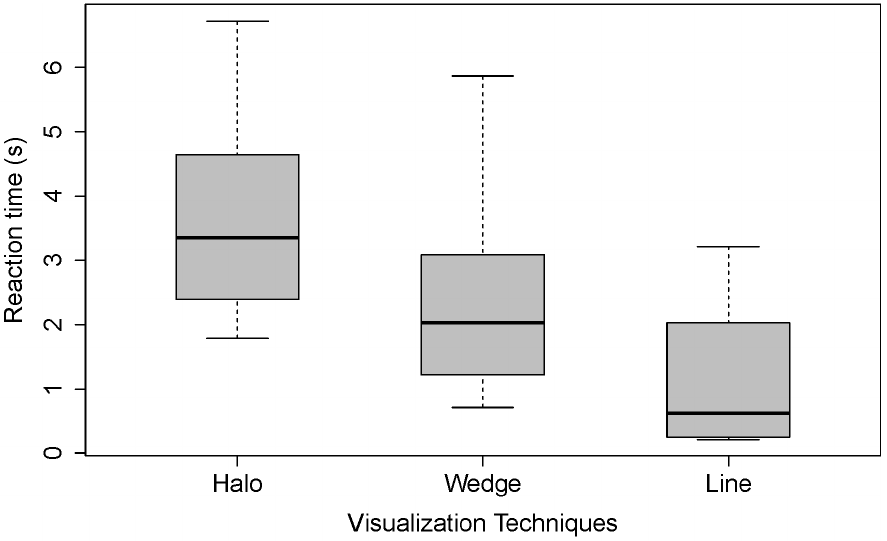
Figure 5. Comparison of the reaction times for the three different visualization techniques: Wedge ; Halo ; and Line .